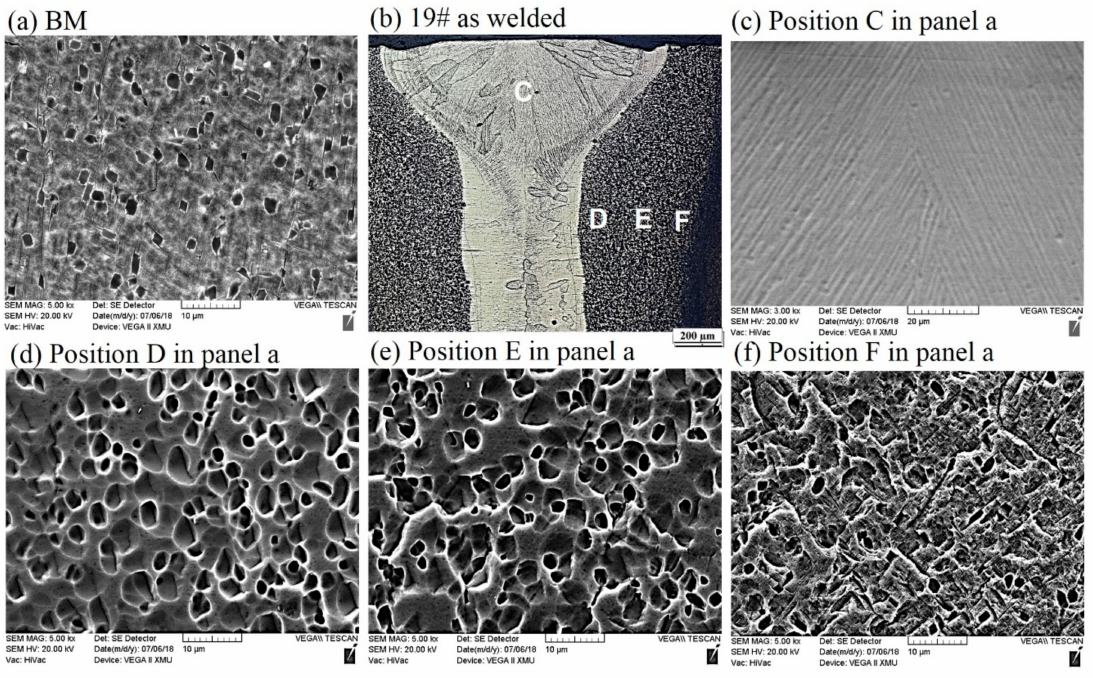
Figure 6. Microstructures of ( a ) BM, and ( b ) cross sections of as-welded Ti55531 joints, accompany with high magnification figures ( c – f